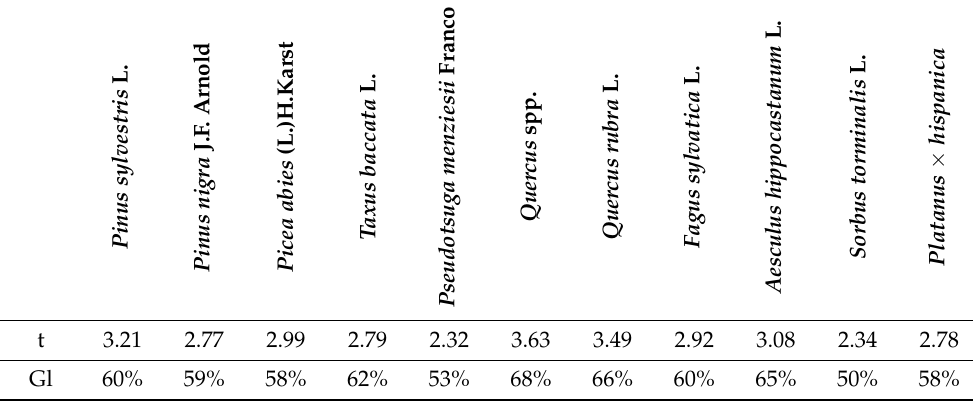
Table 1. Similarity between intermediate hawthorn ( Crataegus media , ST) chronology and local chronologies for other tree species growing in NW Poland, expressed as Student’s t -test and Gl (Gleichläufigkeitswert)